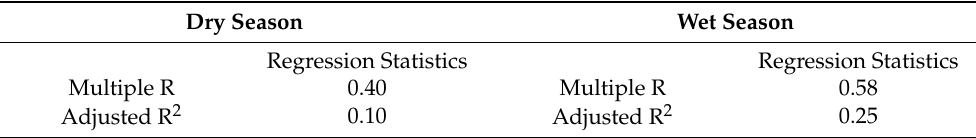
Table 4. Regression statistics for the AOD–PM 2.5 relationship in the dry and wet seasons (seasonal model setup).